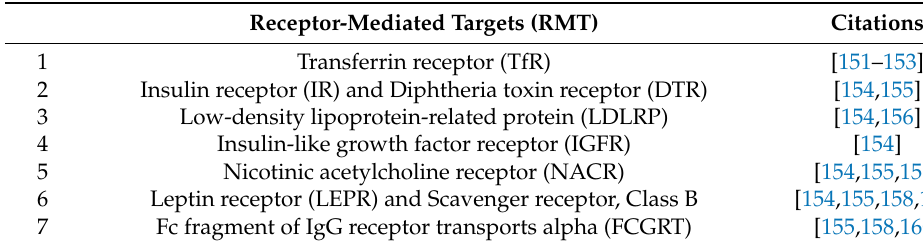
Table 4. The main blood–brain barrier transporters.